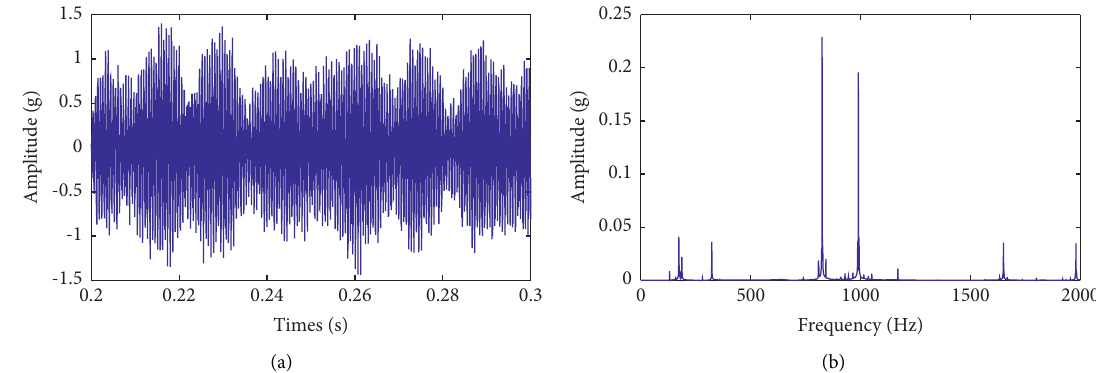
Figure 16: Simulation acceleration values at measuring point 2. (a) Simulation results for time domain acceleration at measuring point 2. (b) Simulation results for frequency domain acceleration at measuring point